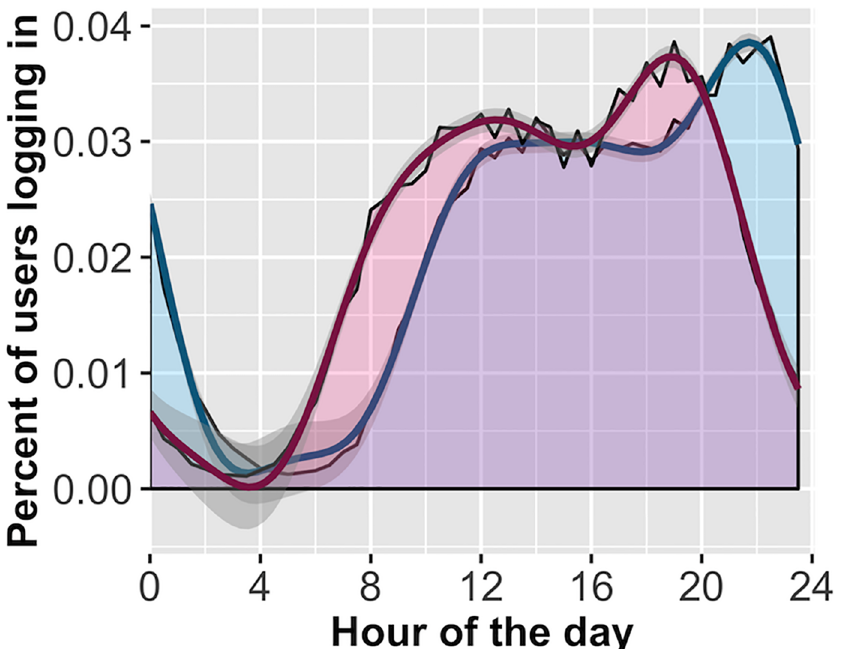
Fig 6. Login activity with 4th harmonic regression line. Notes: red is sample 1, blue is sample 2. Area plots displayedwith data-fit 4th harmonic regression lines. Both samplesexhibit a characteristic increase in login activity early in the day, followedby consistent activity that peaks late in the night. Sample 2 is adjusted for local time zone, which reveals login activity does not declineuntil around2am. Black lines follow the density for each 30-minutewindow,colored lines represent regression function, grey shadedribbons are 95% CI of the regression line.